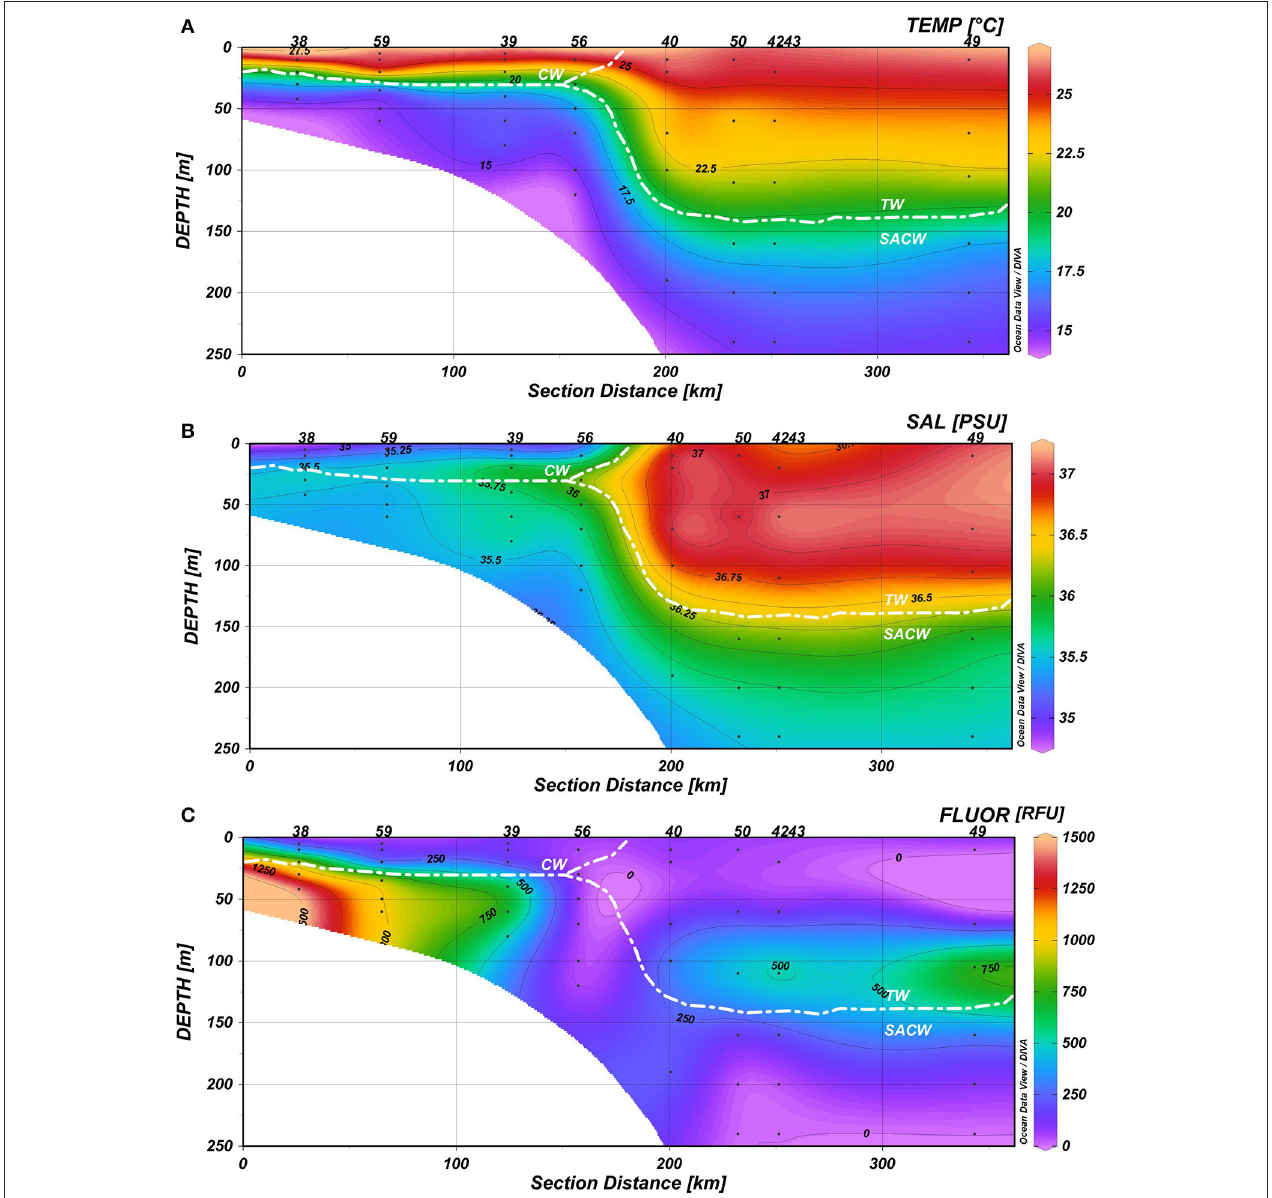
FIGURE 4 | Hydrographic conditions of the water column (0–250 m) in a 350 km transect: (A) Temperature ( ◦ C), (B) Salinity (psu), and (C) Fluorescence (RFU). Station labels are indicated at the top of each panel (38, 59, 39, 56, 40, 50, 42, 43, and 49 along a transect from the coast to the ocean).